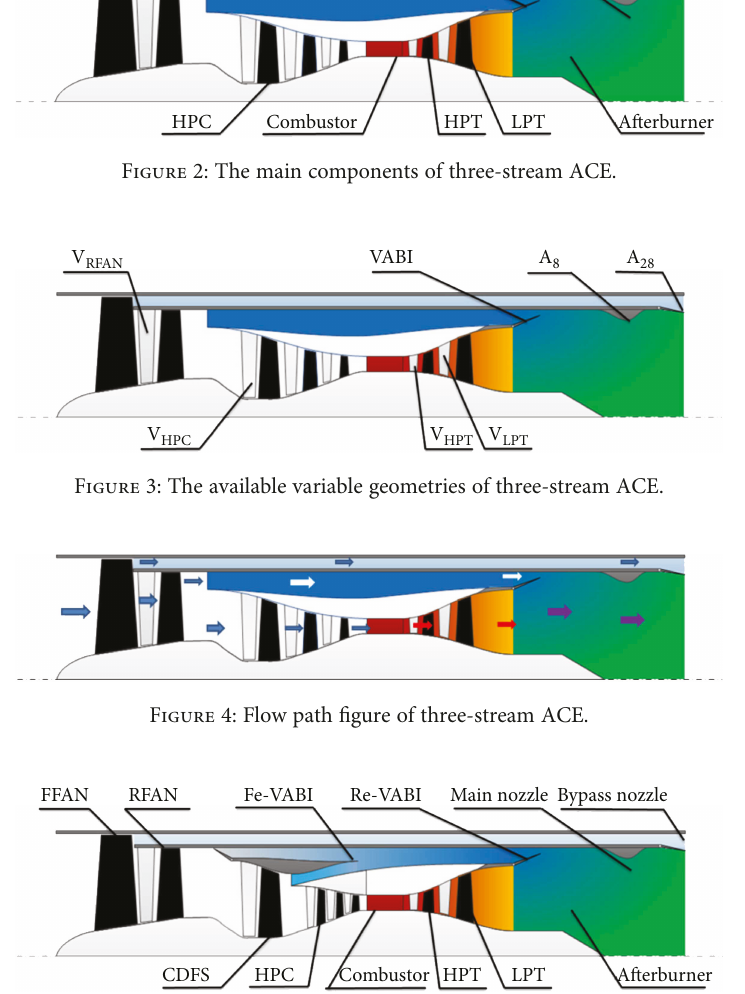
Figure 5: Structure fi gure of three-bypass